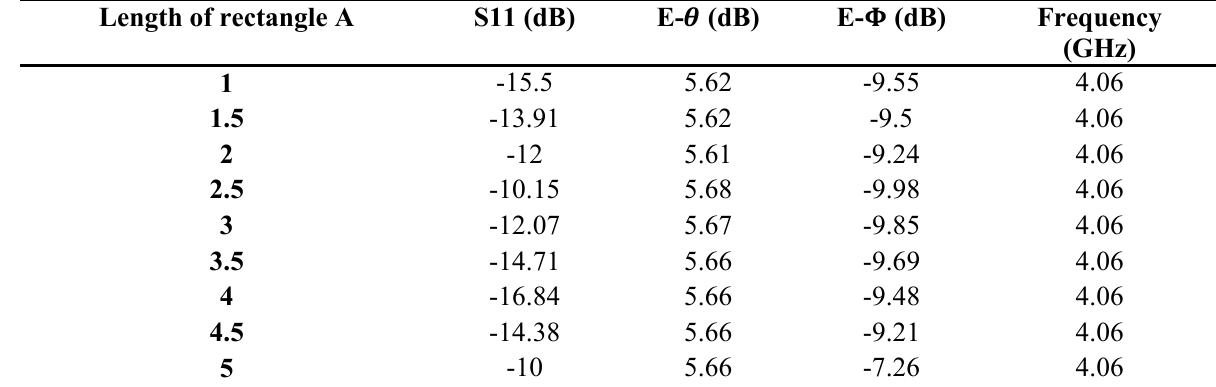
Table 1. Results of first parametric study